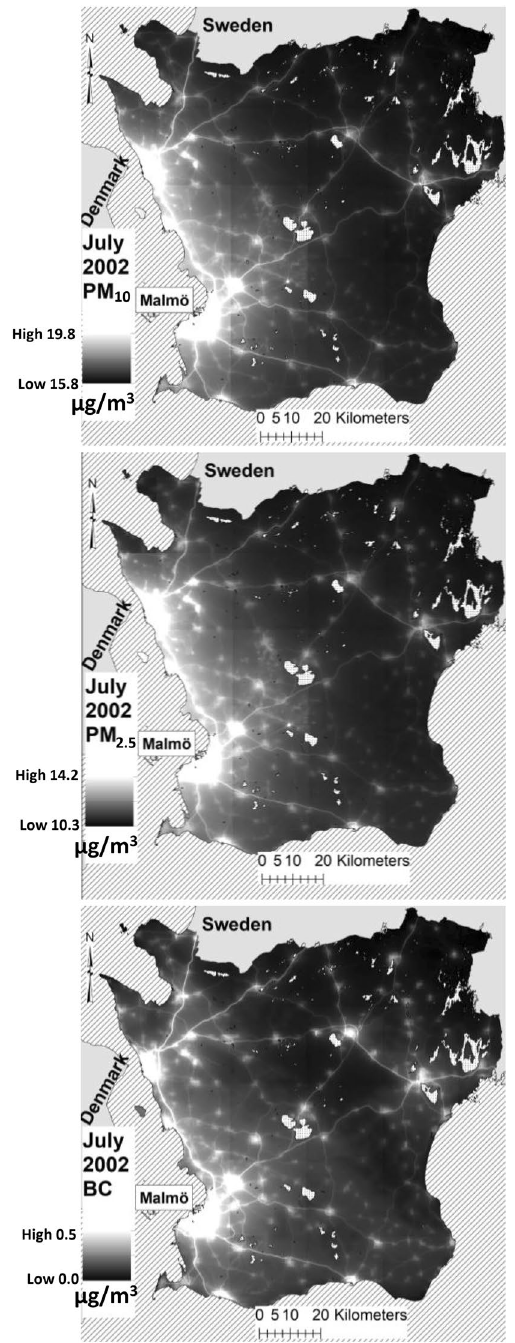
Fig. 7 Concentrations of PM ary 2002 with background levels added where possible Fig. 8 Concentrations of PM